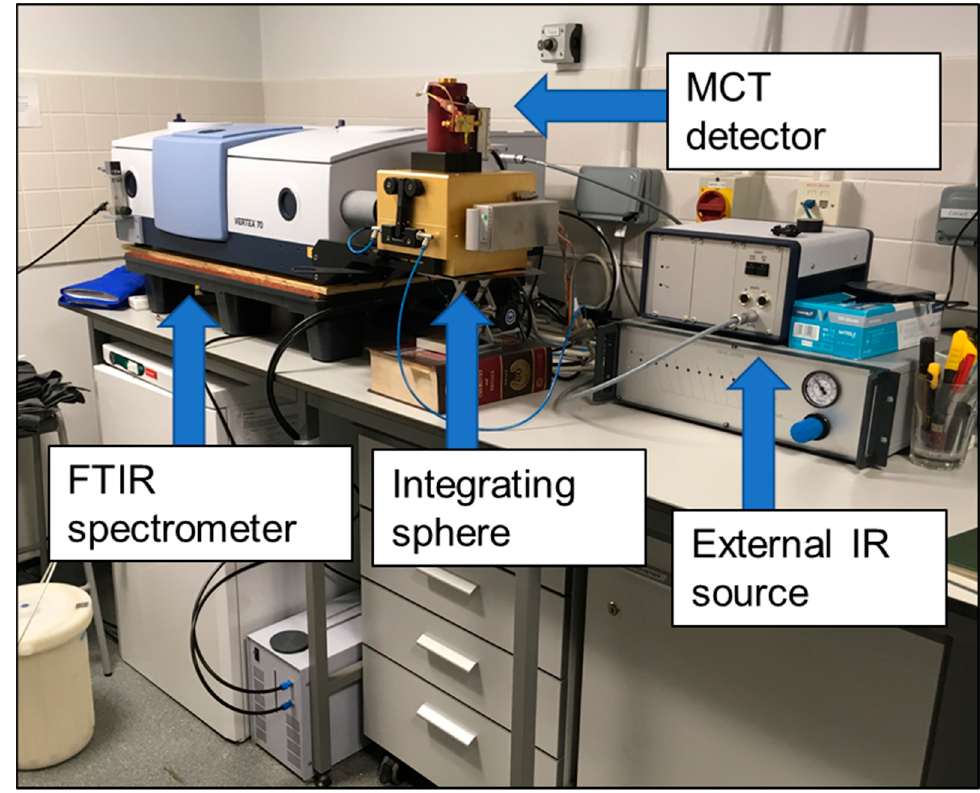
Figure A1. The VERTEX 70 spectrometer setup at King’s College London with details highlighted. Table A1. Standard measurement settings for the VERTEX 70 Spectrometer setup at King’s College